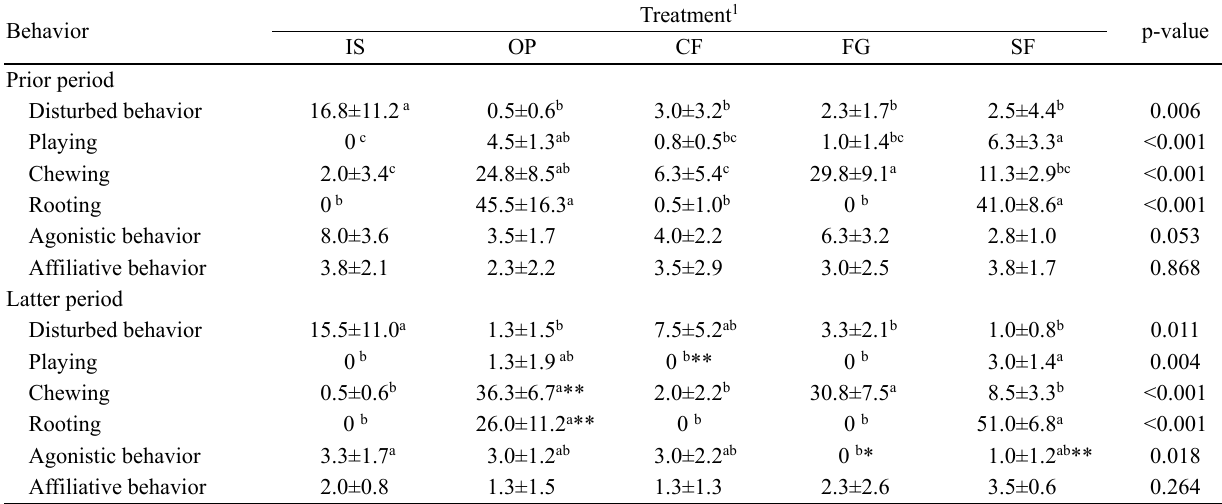
Table 4. Frequencies of behavioral events in pigs in the five